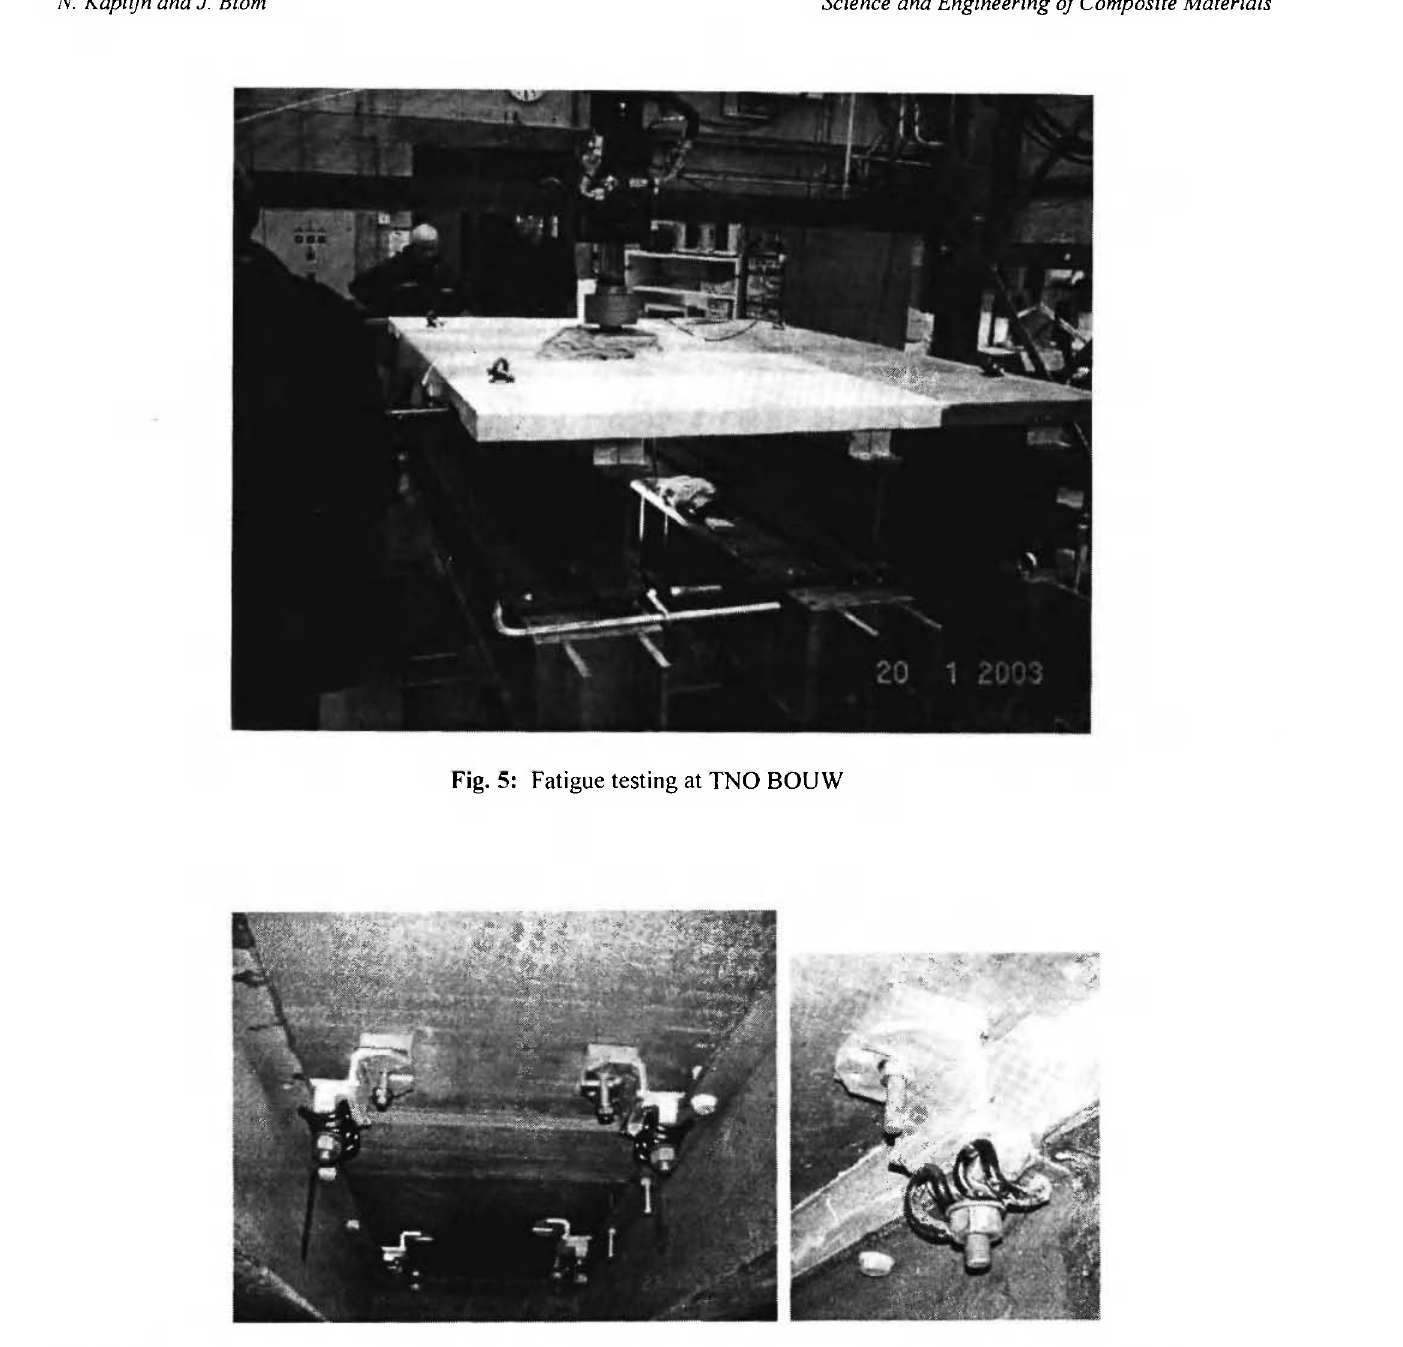
Fig. 6: Fixing the panels to the steel girders. Note the bolts on the right (left photograph) for height adjustment of the panel edges. On the right photograph the PU filling has not yet been placed.